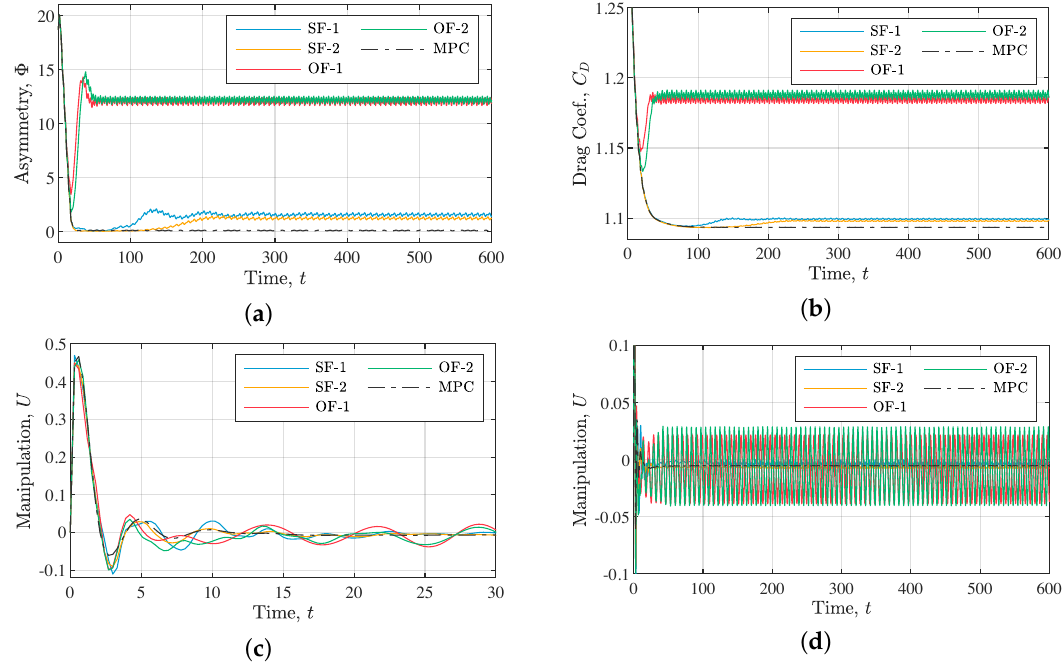
Figure 13. Plots of ( a ) the asymmetric function, ( b ) the drag coefficient, ( c ), ( d ) the control input. The cyan, yellow, red, green, and dashed lines respectively show the results under the control laws (SF-1), (SF-2), (OF-1), (OF-2), and the